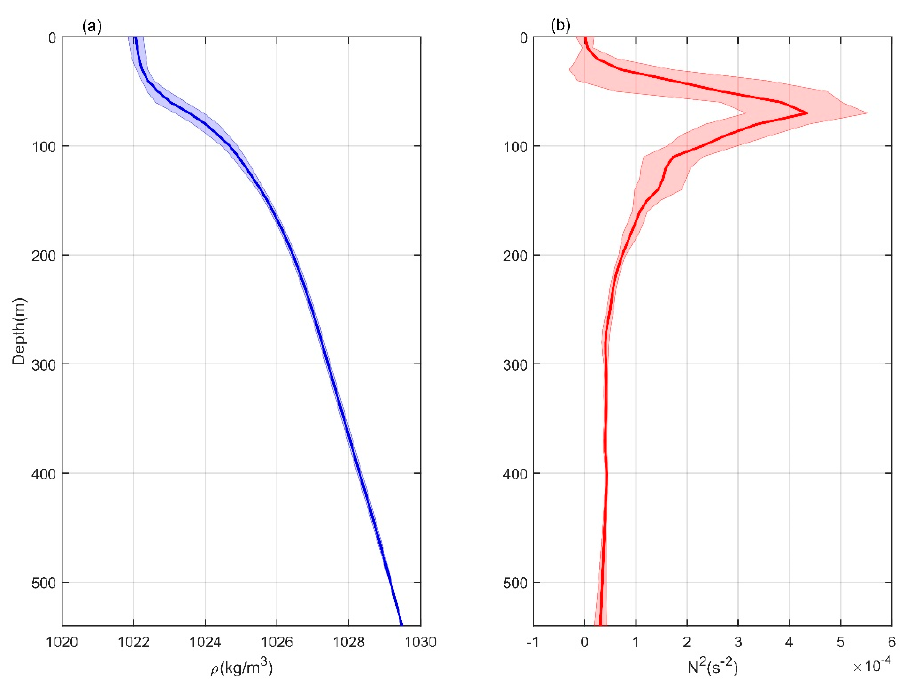
Figure 3. Vertical profiles of the time-averaged density ( a ) and buoyancy frequency squared ( b ). The light blue and red shading indicate the standard deviation in ( a ) and ( b ), respectively.